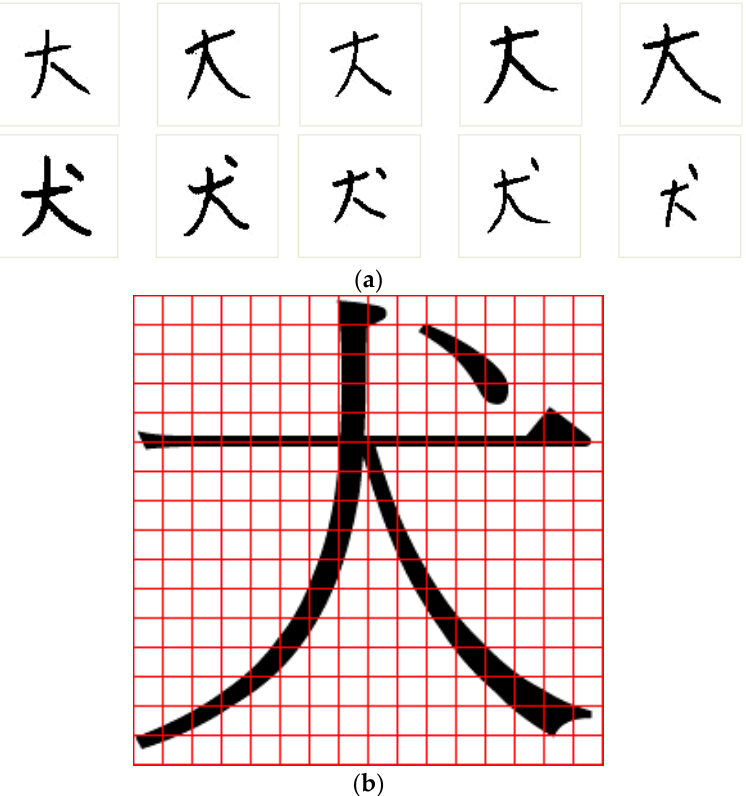
Figure 7. ( a ) Some examples of Chinese characters “ 大 ” and “ 犬 ”; ( b ) A character image is transfer as 256 feature vectors.